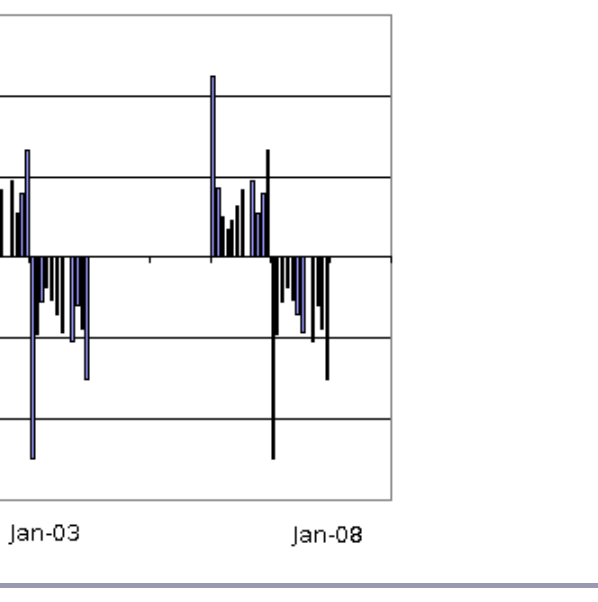
Fig. 7 . Percent difference in headflow, with decision tree vs. only